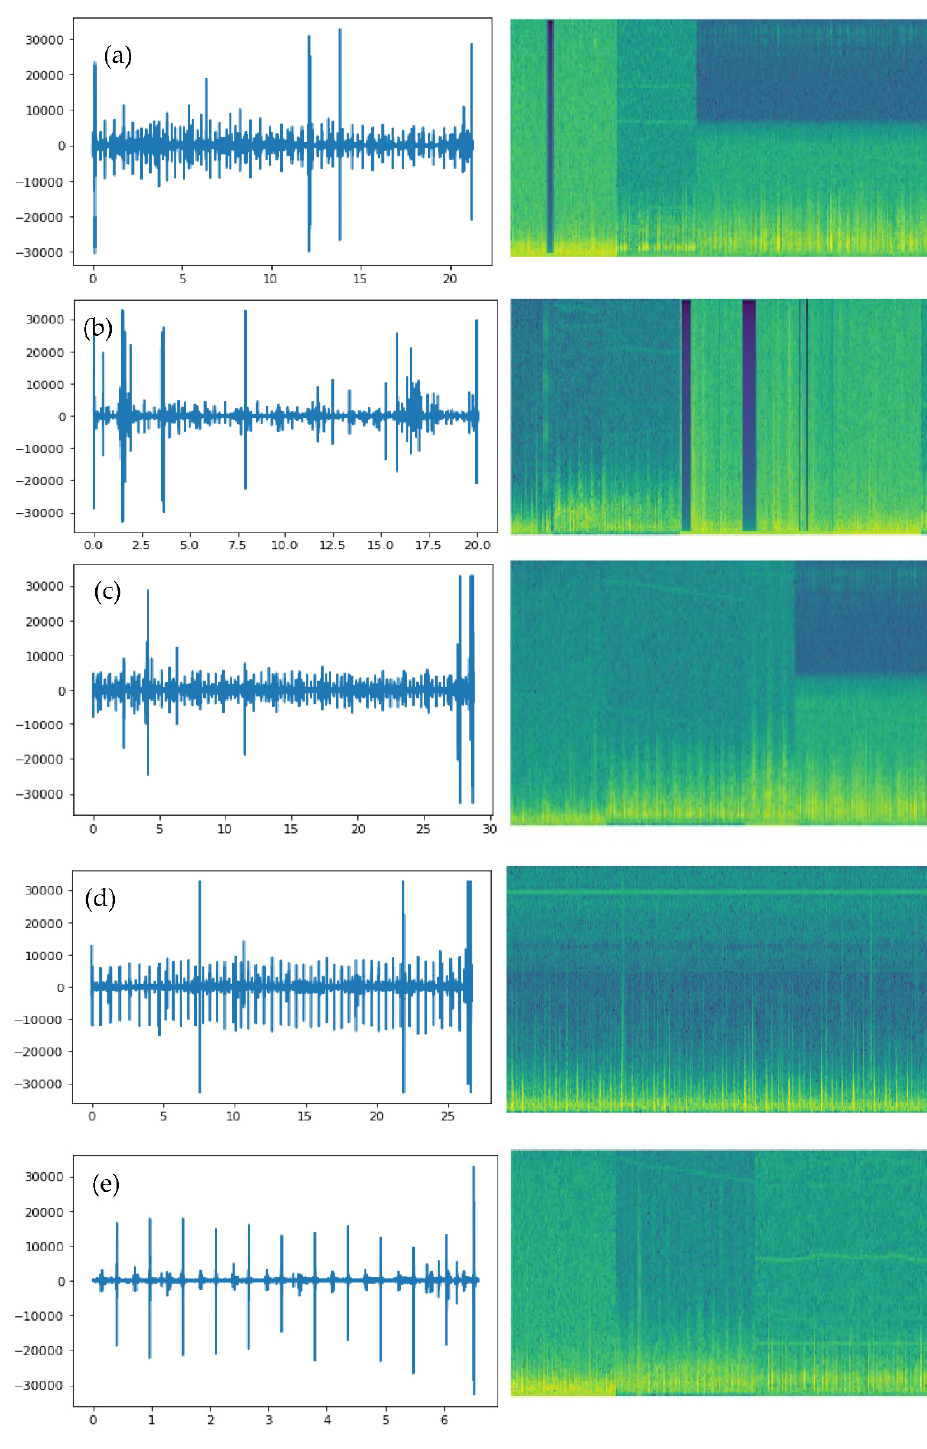
Figure 3. An example of a signal transform step after preprocessing through the continuous wavelets transform-based spectrogram (CWTS) approach. ( a ) Aortic stenosis (AS), ( b ) Mitral regurgitation (MR), ( c ) Mitral stenosis (MS), ( d ) Mitral valve prolapse (MVP) and ( e ) Normal.